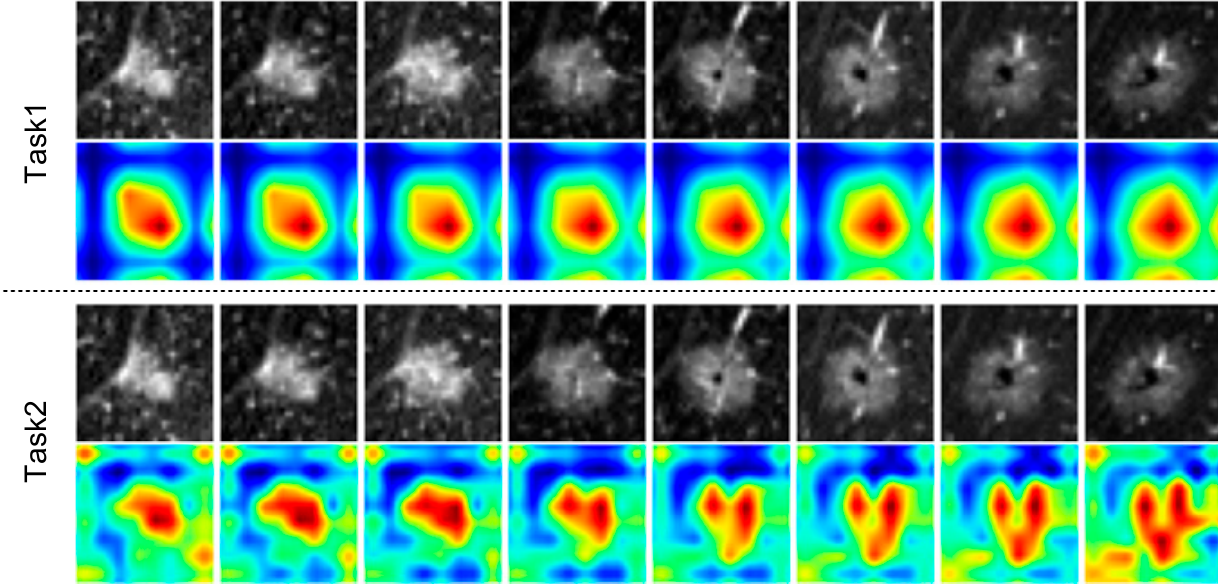
Figure A3. The training accuracy and loss curves for Task1 and Task2, respectively. The red dotted line marks the stopping point in the training process.